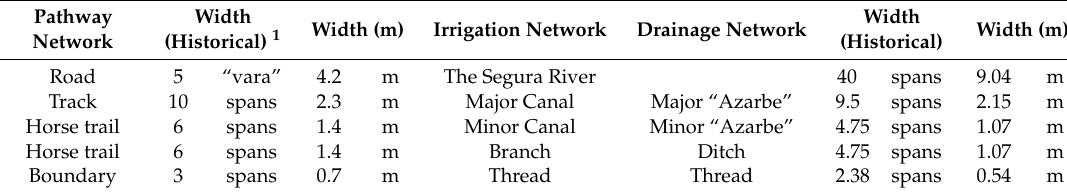
Table 1. Relation between pathway network and canal bank widths (irrigation and drainage) at Vega Baja of the Segura River, 19th